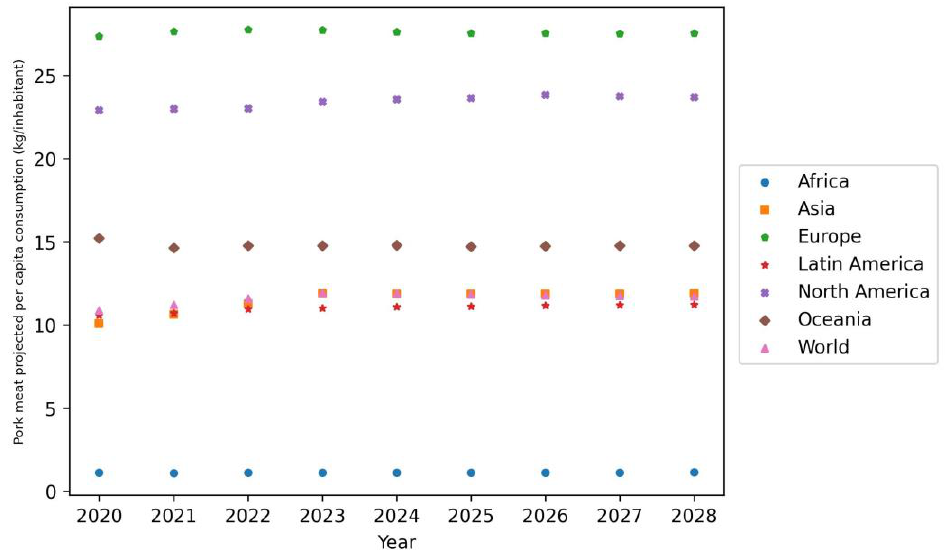
Figure 3. Pork meat projected per capita consumption in the 2020–2029 period. Source: OECD (2023), Meat consumption (indicator). https://doi.org/10.1787/fa290fd0-en (accessed on 10 January